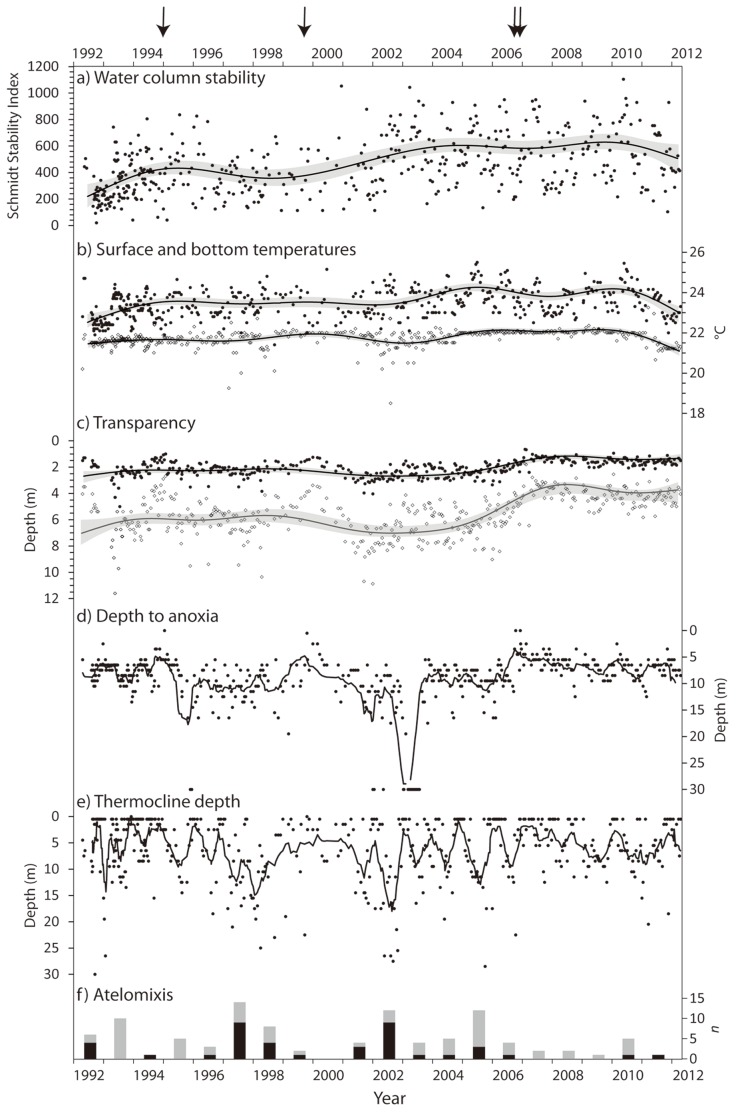
Water column data in Lake Nkuruba 1992–2012.Arrows indicate the timing of observed mixing events. a) thermal stability of the water column at the time of sampling expressed using the Schmidt Stability Index computed following [27]; line indicates trend; b) surface (black circles) and bottom (open diamonds) water temperatures; c) Secchi (black circles) and photic zone (open diamonds) depths (photic zone = Secchi×2.7 [28]); d) depth to anoxia determined as the depth at which dissolved oxygen measurements drop below 1 mg L−1; e) thermocline depth determined as the depth where the greatest inflection in the temperature curve occurs over a thickness of 1 m; f) annual occurrences of atelomixis events identified by thermocline depths greater than 15 m (black bar) or situated between 15 and 10 m (grey bar). For a–c) lines and grey bands indicate the nonlinear (GAM) response curves and the 95% confidence intervals, respectively. For d–e) lines indicate a 10-point running mean.